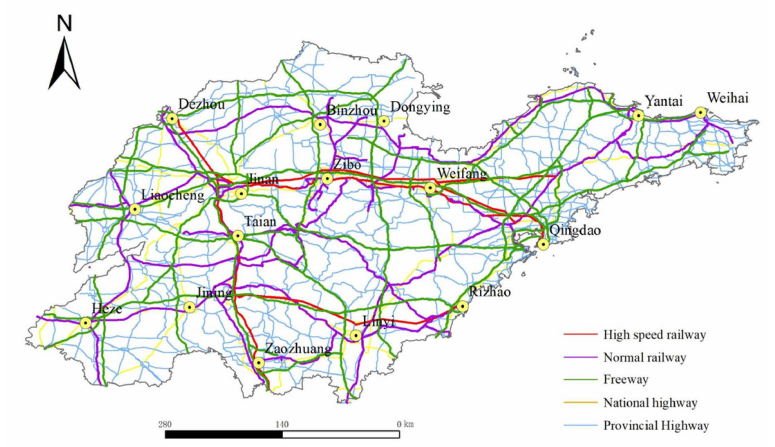
Figure 1. Road network of Shandong Province, China, in 2020.